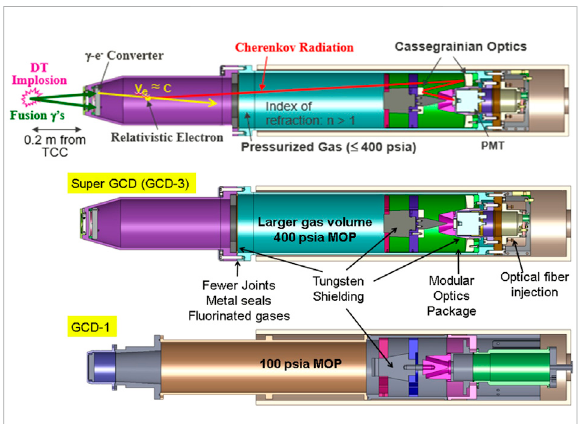
FIGURE 1 Schematic showing design of GCD-1 and GCD-3. The top diagram illustrates thegeneral operation of these similar detectors while the lower two diagrams show the differences in design betweenGCD-1andGCD-3.ThesedetectorsuseCherenkov radiation in high pressure gases to detect incident gamma rays. Thethresholdcanbeadjustedbychangingthepressureofthegas. GCD-1 can also use other materials such as fused silica or aerogel radiators. These diagnostics are re-entrant diagnostics on OMEGA and the NIF. They are generally fi elded close to TCC to maximize solid